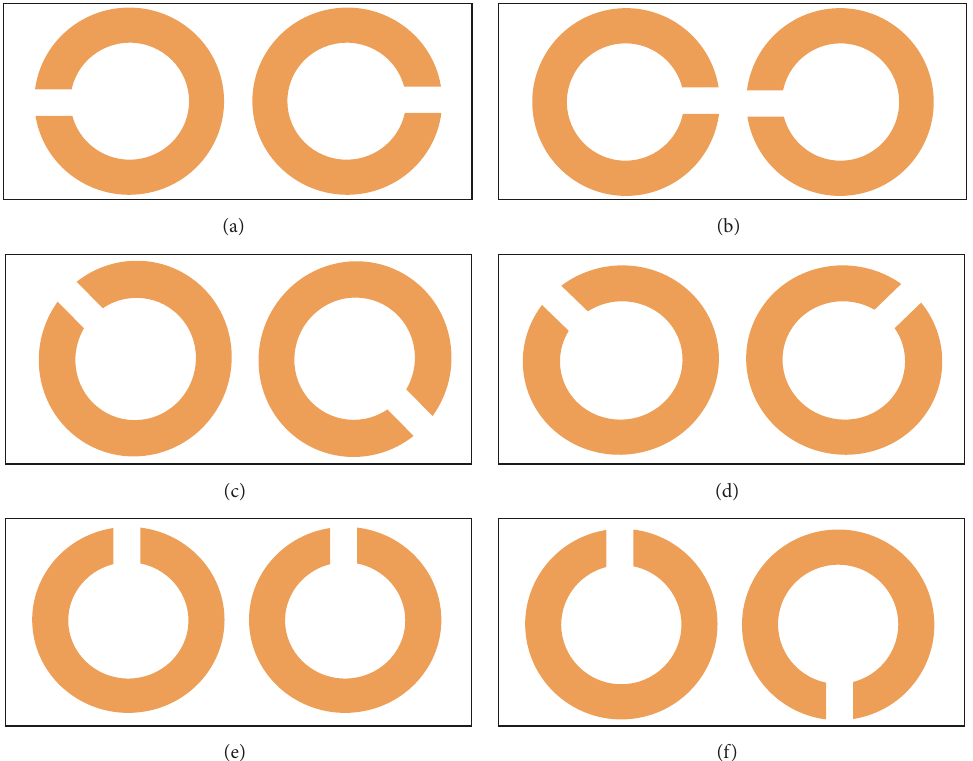
Figure 5: Different orientation of two rings: (a) 180 ∘ and 0 ∘ , (b) 0 ∘ and 180 ∘ , (c) 135 ∘ and − 45 ∘ , (d) 135 ∘ and 45 ∘ , (e) 90 ∘ and 90 ∘ , and (f) 90 ∘